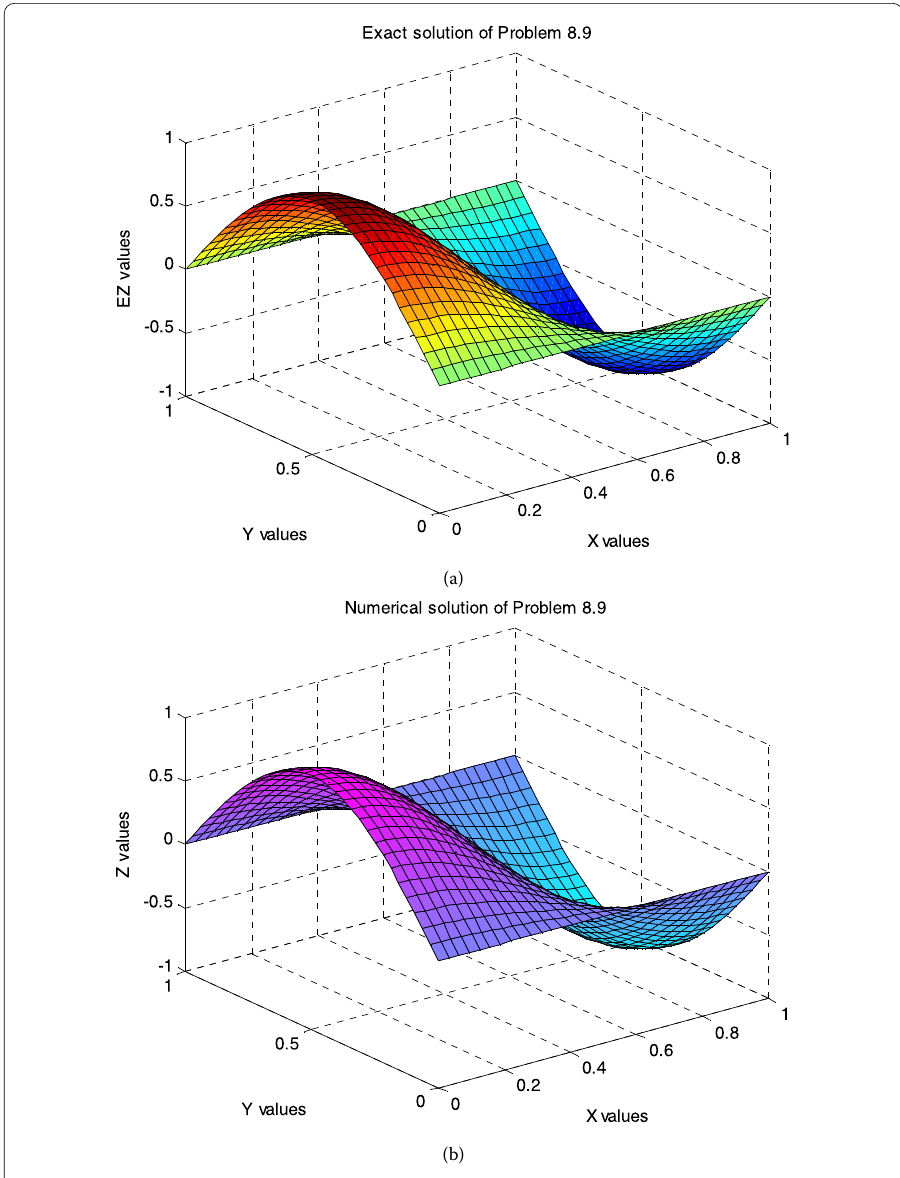
Figure 10 ( a ) Exact solution of Problem 8.9 for h = 1/32 and α = 10. ( b ) Numerical solution of Problem 8.9 for h = 1/32 and α = 10